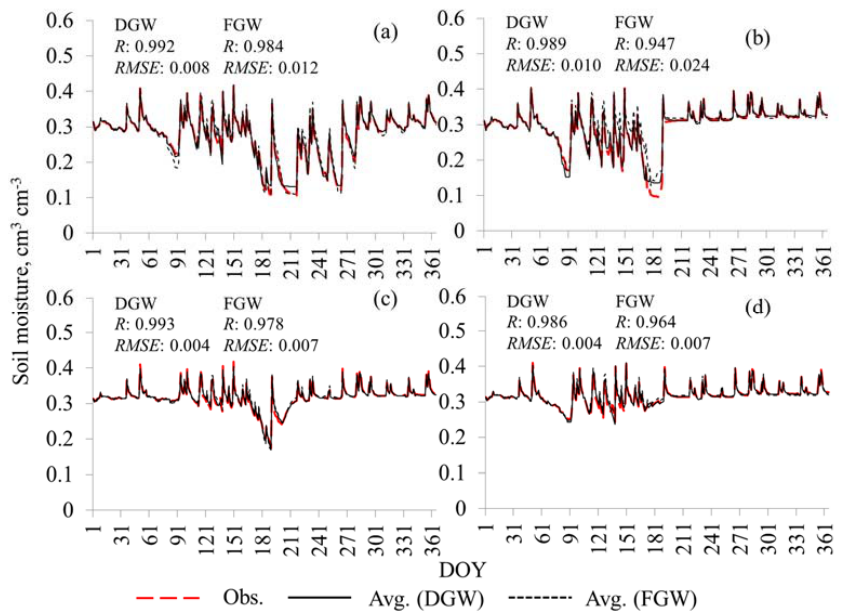
Figure 5. Comparison of observed and ensemble averaged root zone soil moisture dynamics at ARS 136 site in Oklahoma (1997) under synthetic conditions; ( a ) grass; ( b ) wheat; ( c ) soybean; and ( d ) maize. Number in ensemble: 100. Table 2. Observed and simulated soil hydraulic properties at Agricultural Research Service (ARS) 136 site in Oklahoma (1997) with silt loam soil and various vegetation covers under synthetic conditions.